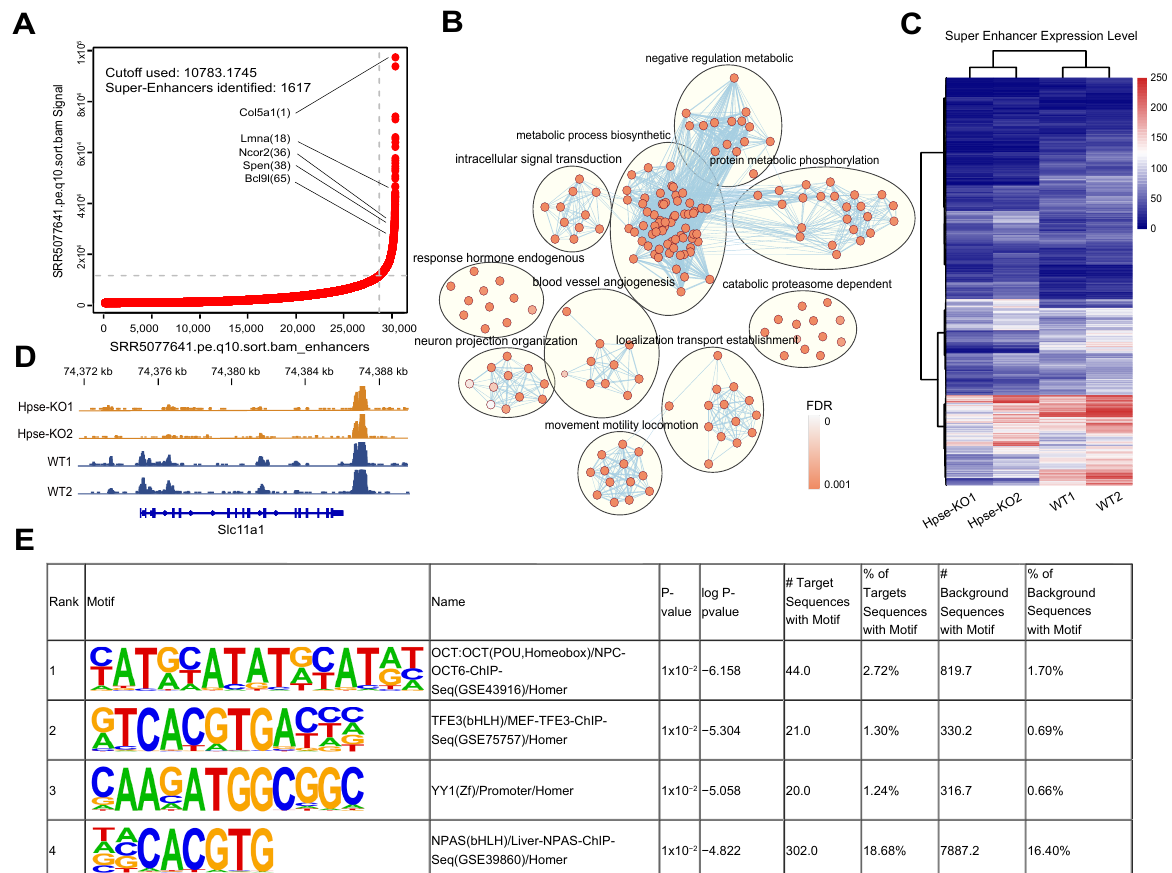
Figure 3. Identification and functional characterization of super-enhancers. ( A ) Rank ordering of super- enhancers with representative SE-associated genes. ( B ) Ontological enrichment of SE-associated genes. ( C ) Heatmap displays the peak counts of super-enhancers in WT and Hpse-KO cells. ( D ) Genome track showing reduction of ATAC-seq signal in the super-enhancers region of Hpse-KO cells. ( E ) Motif analysis of